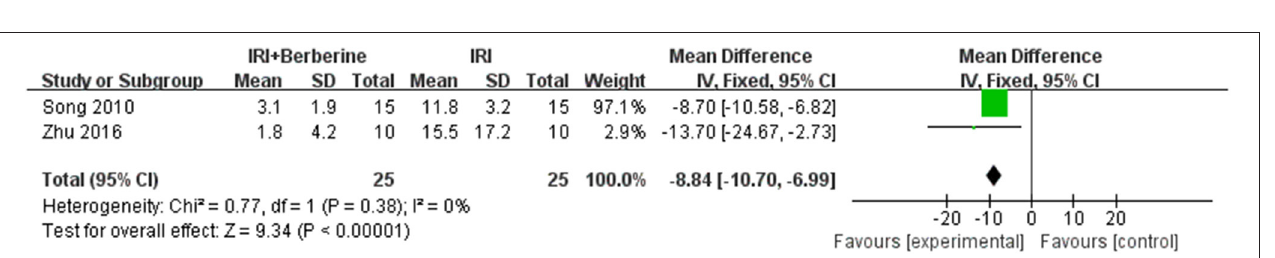
to analyze the levels of myocardial apoptosis. The level